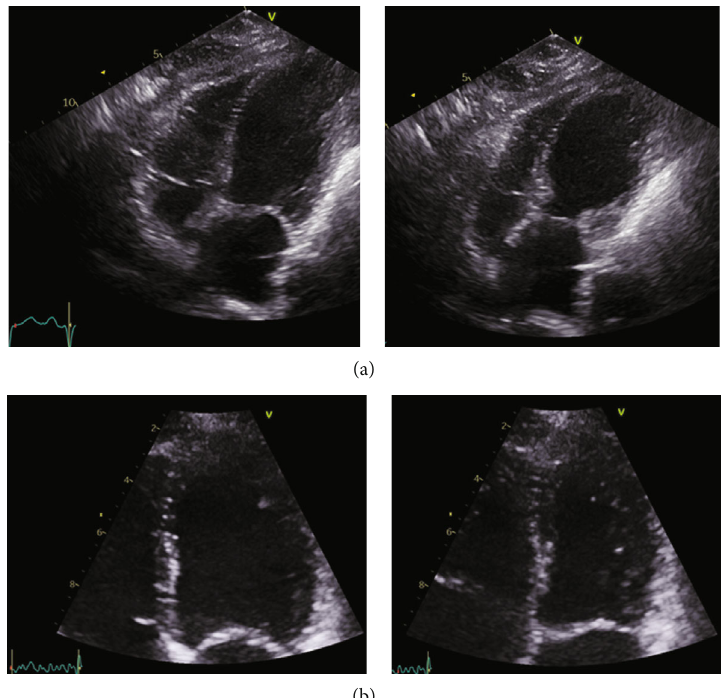
Figure 1: (a) Echocardiography in the acute phase. The fi rst echocardiography showing modi fi ed 4 ch view of end-diastolic and end-systolic left ventricular volume. Basal hypercontraction and apical ballooning is evident, interpreted as acute heart failure/takotsubo cardiomyopathy. (b) Echocardiography after remission of tension pneumothorax and subcutaneous emphysema. Follow-up echocardiography showing 4 ch view of end-diastolic and end-systolic left ventricular volume 1 month later. Left ventricular ejection fraction (LVEF) has